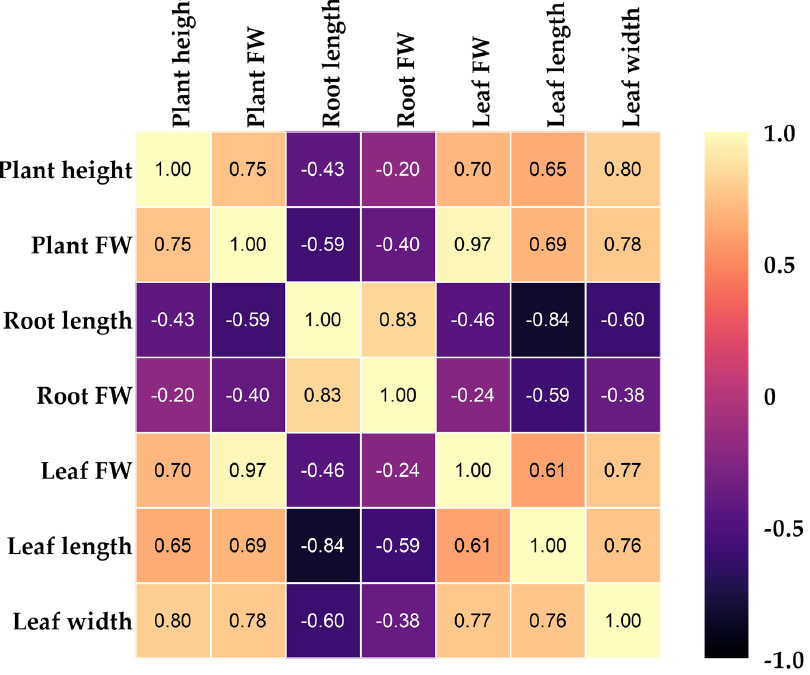
Figure 3. Principal component analysis of agronomic attributes corresponding to the treatments.